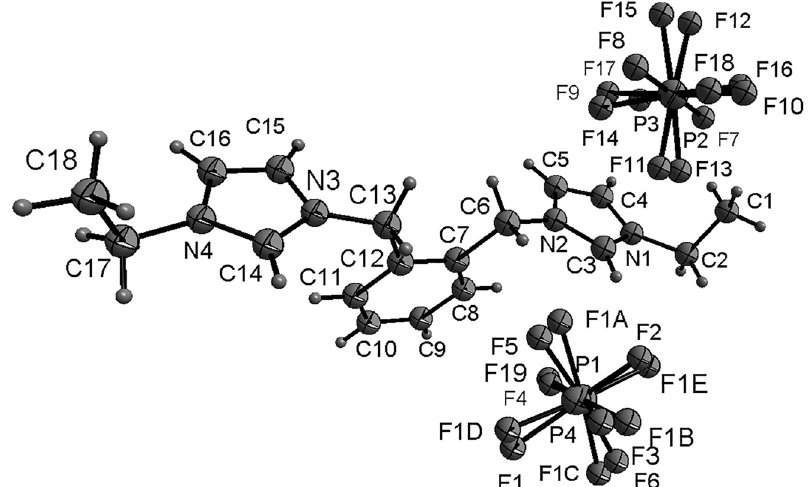
Table  : Data collection and